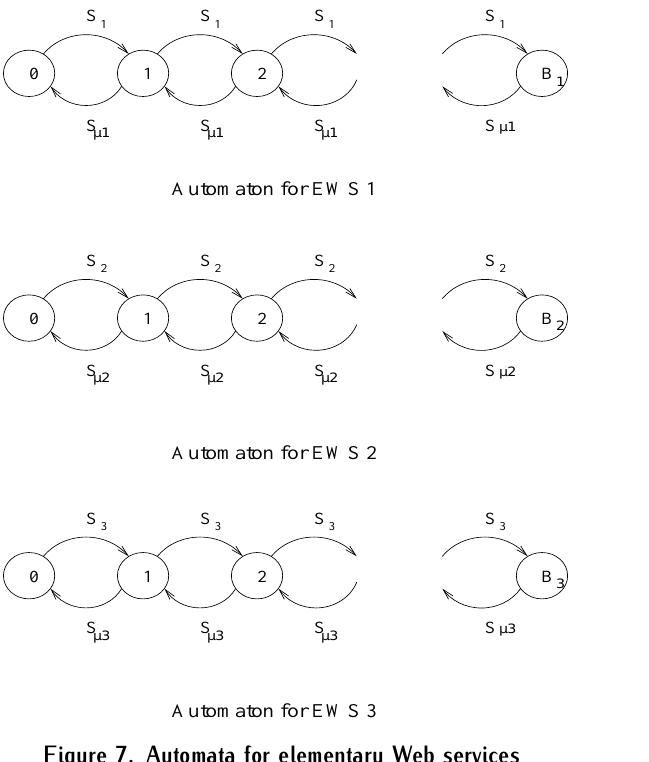
Figure 11. Mean Response times for the case n is constant.